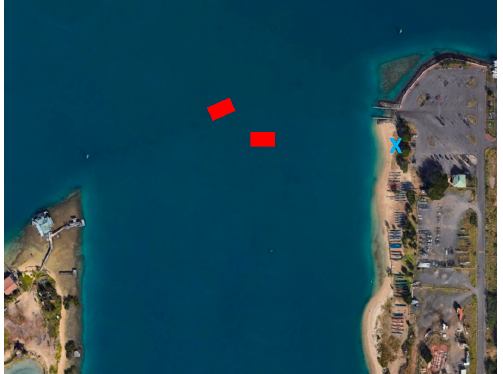
Figure 3. Satellite map of Sand Island. The red boxes represent the approximate locations where the mock UXO ladder was deployed. The blue X represents the approximate location of the ground station.